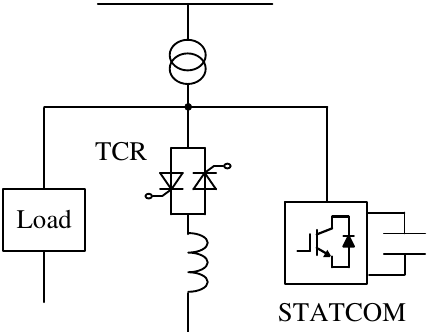
Figure 3. Power circuit diagram of the previously proposed hybrid static VAR compensator (SVC) with a static synchronous compensator (STATCOM)